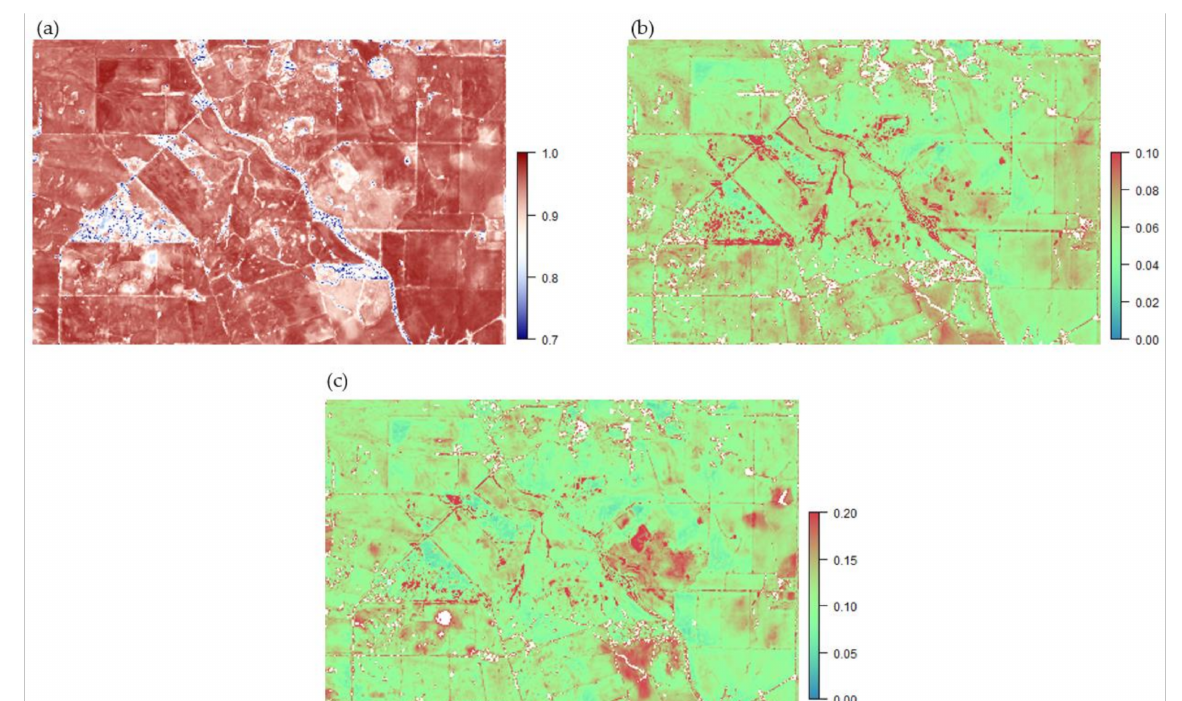
Figure 6. Per-cell accuracy of the SWGC method NDVI prediction for the Landsat-8 test data: ( a ) correlation; ( b ) MAE and ( c )